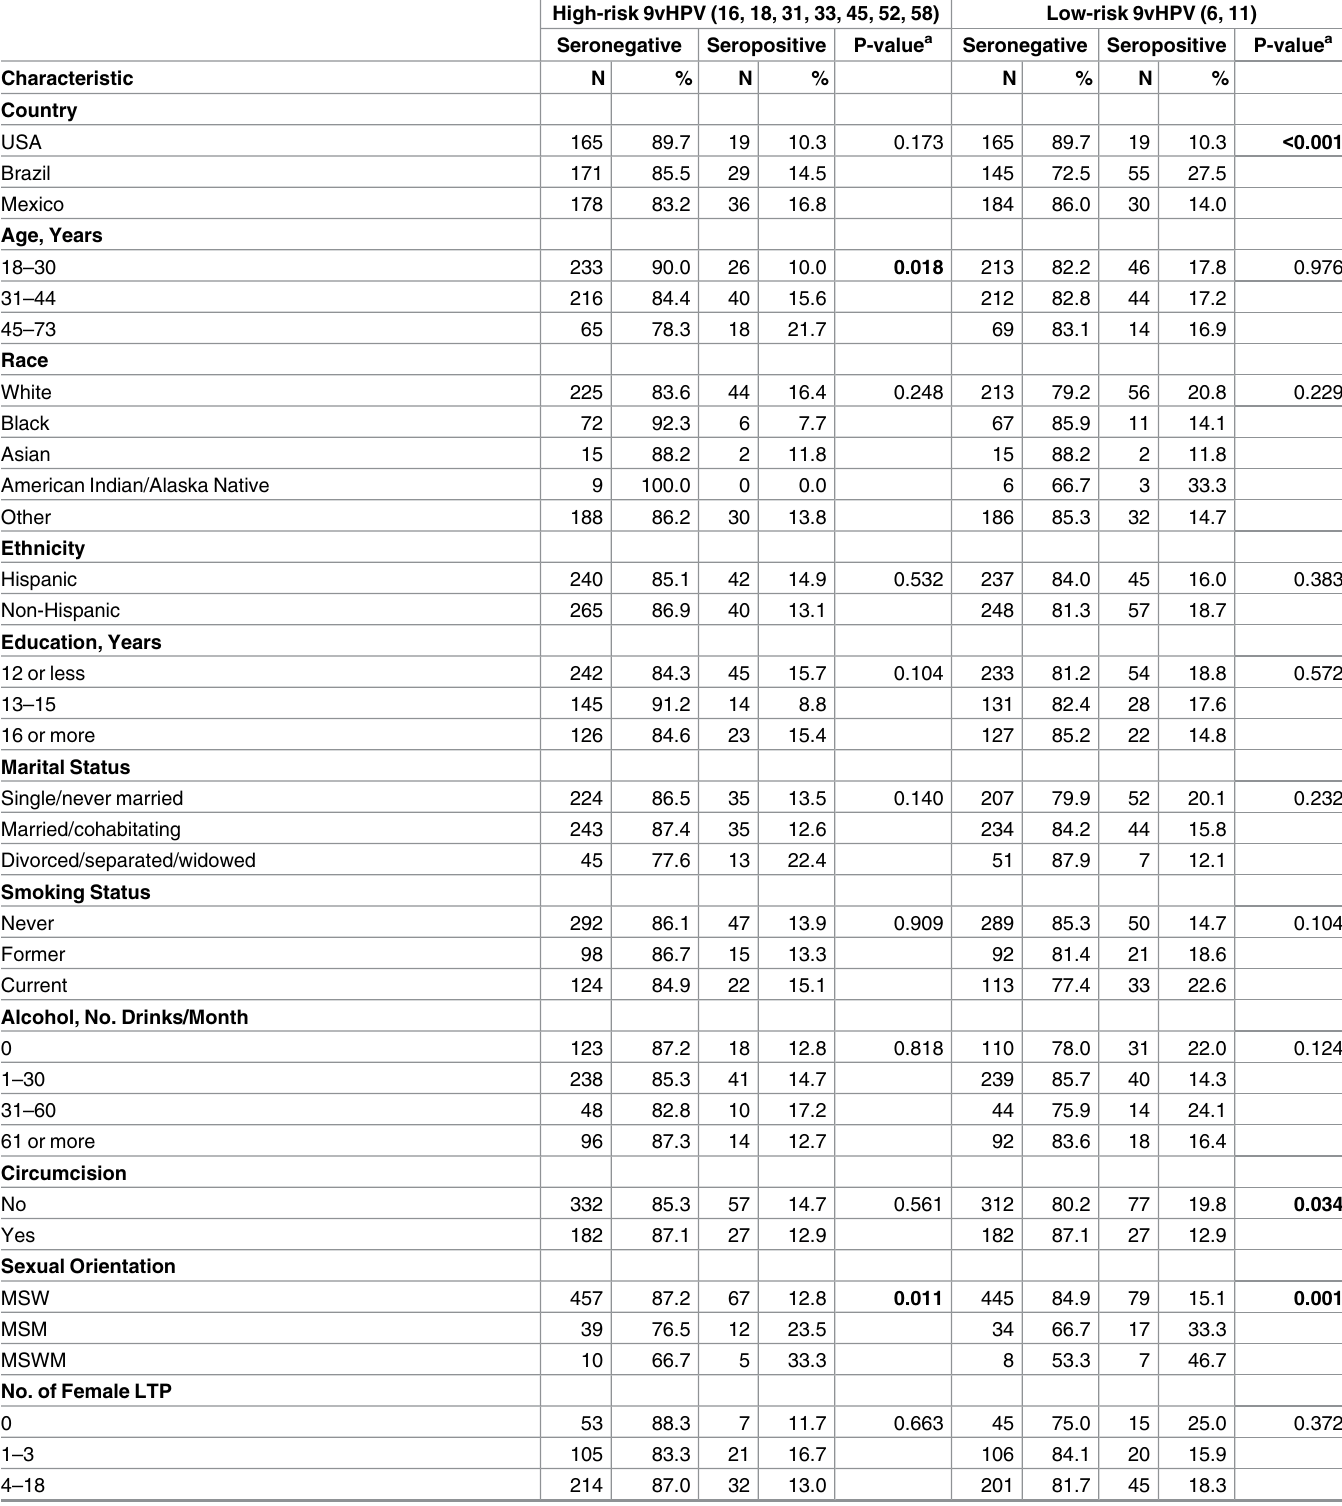
Table 1. Participant characteristics by seropositivity to high-risk and low-risk types in 9vHPV